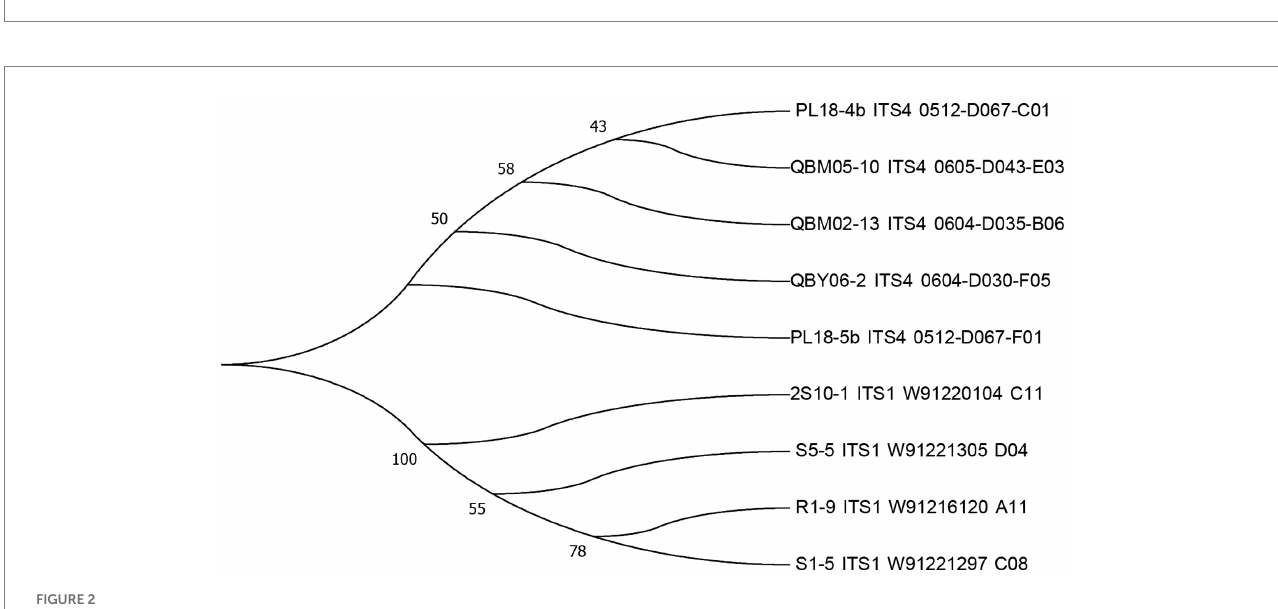
FIGURE 1 The positive rate of mycotoxins in 145 crop samples.